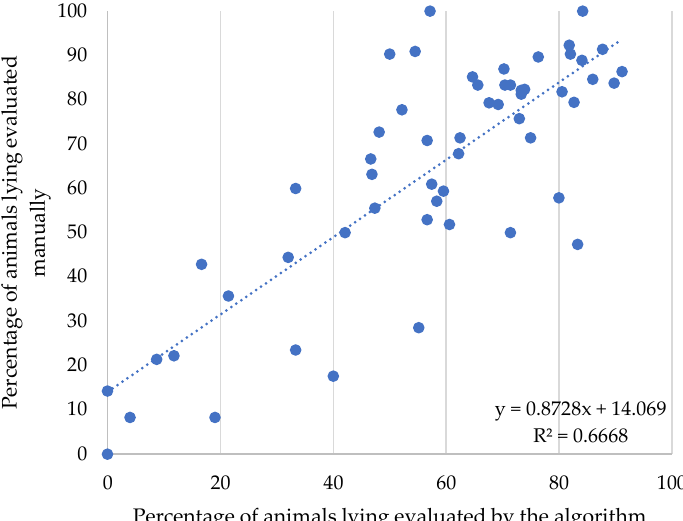
Figure 6. Dispersion for percentage of animals in manual count versus artificial intelligence count, for lying behavior.